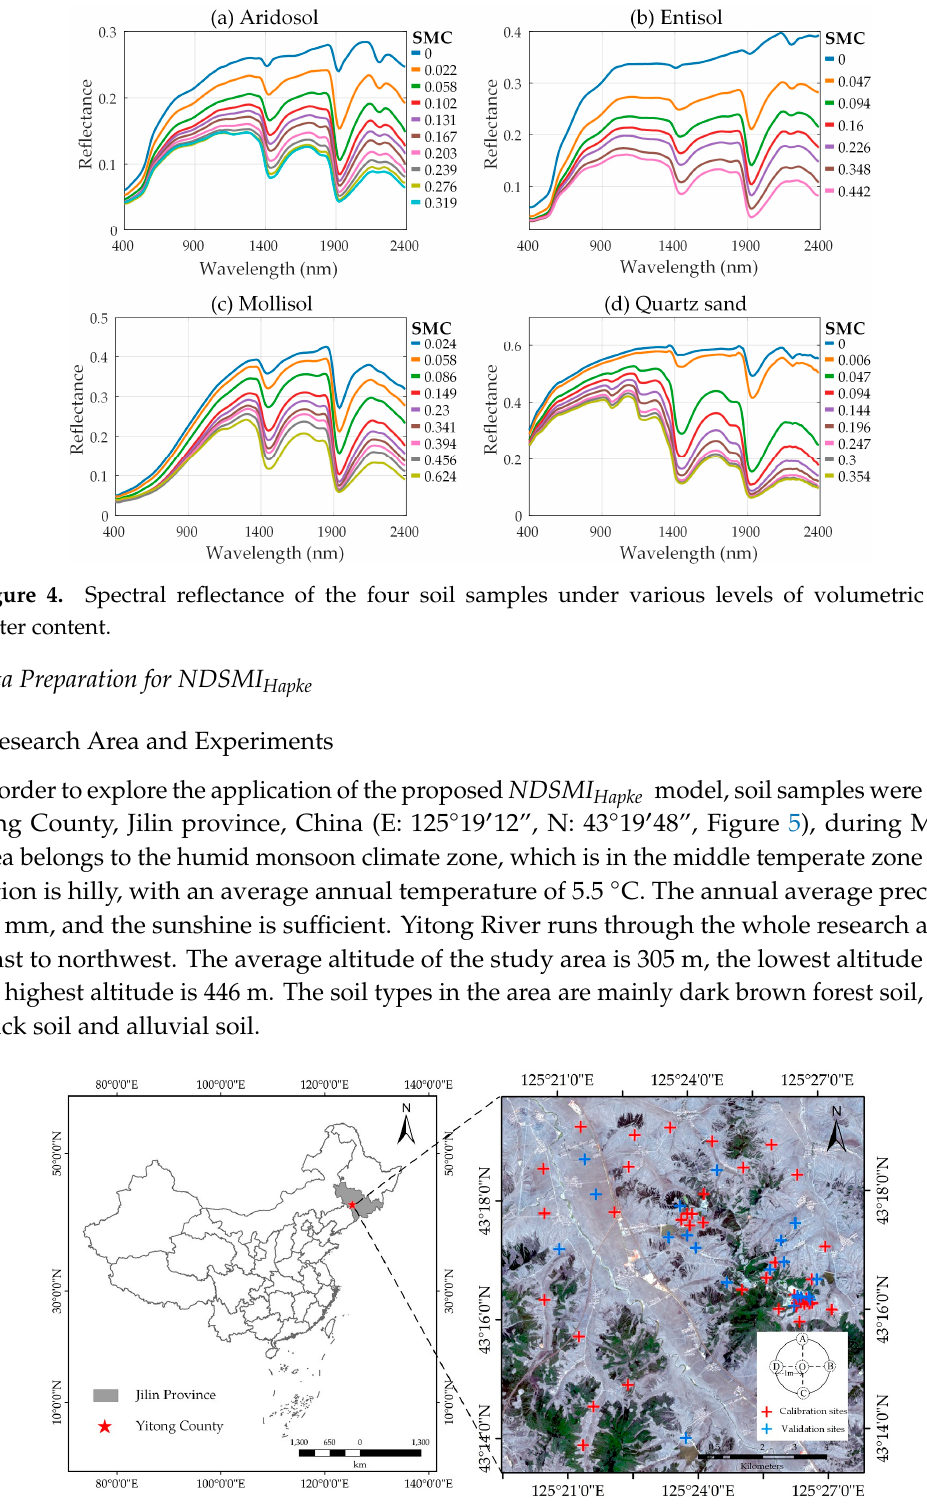
Figure 6. Texture of the studied soil samples. The size of the soil particles was divided into clay ( ≤ 2 μ m), silt (2–50 μ m) and sand (50–2000 μ m) according to the United States Department of Agriculture (USDA) classification. 3.2.2. Laboratory Measurement of Soil Moisture and Hyperspectral Reflectance The hyperspectral data and SMC data were collected as follows. Firstly, the soil samples were removed from the impervious sealed bags, and each sample was divided into two parts. For one part, an ML3X soil moisture meter was used to record the volumetric moisture content of the soil. Meanwhile, the other part was evenly placed into a petri dish, and an ASD FieldSpec 3 portable